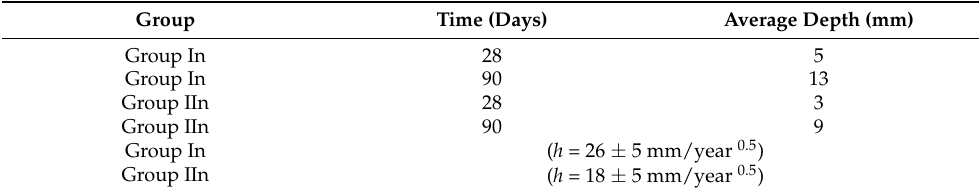
Table 6. Depth values as a function of time for the different groups of